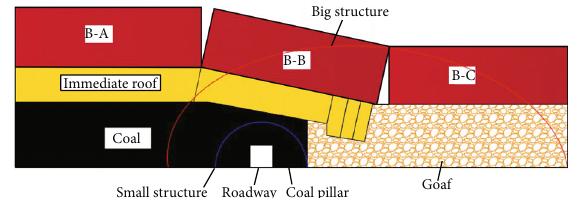
Figure 6: Schematic diagram of big and small structure of surrounding rock in gob-side entry driving.